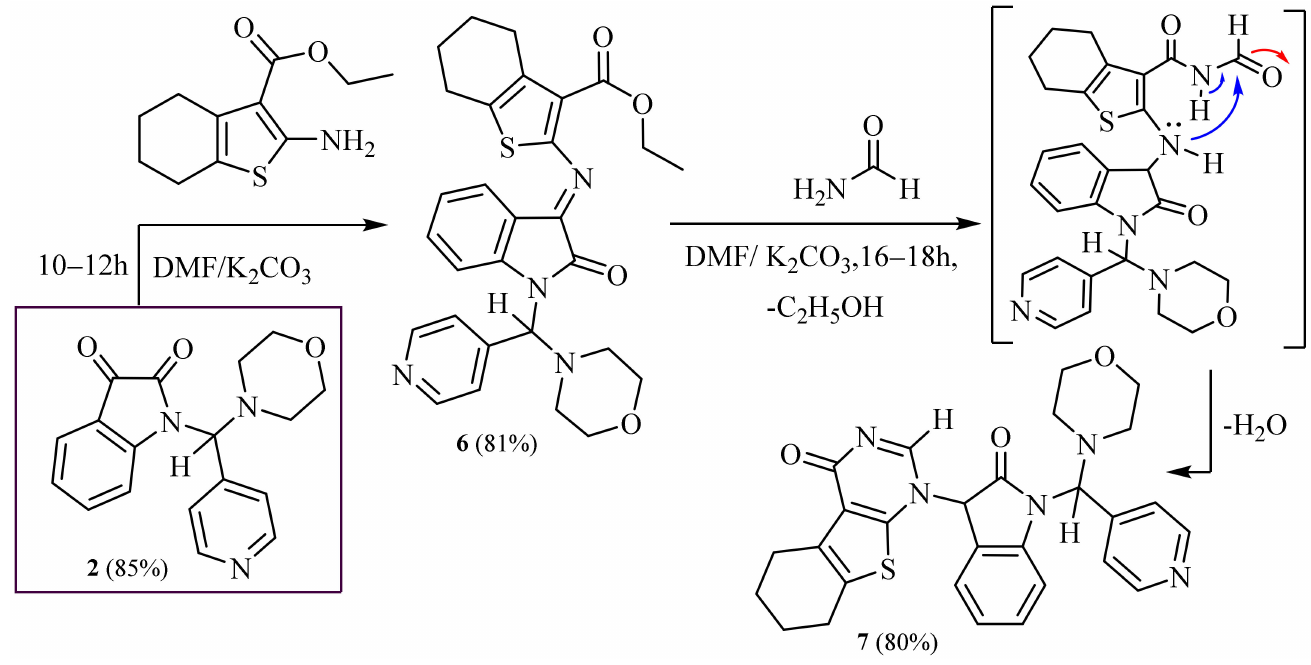
(morpholi- no (pyridin-4-yl) methyl) indolin-2-one (12) in good yield. The IR spectrum compound ( 12) exhibited absorption bands at ν 3410 cm − 1 corresponding to NH 2 group and1684 cm − 1 corresponding to one carbonyl group. 1 H-NMR spectrum of (12)